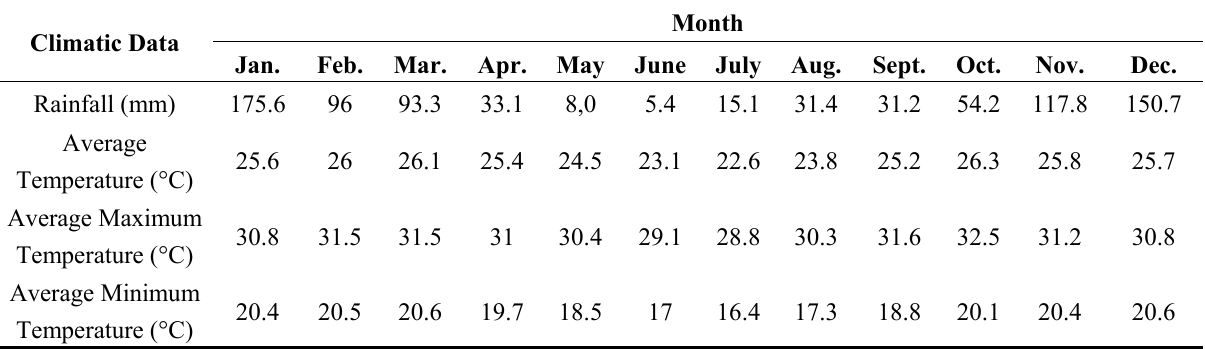
Table 1. Meteorological data of the study area between 1977 and 2007 [27].